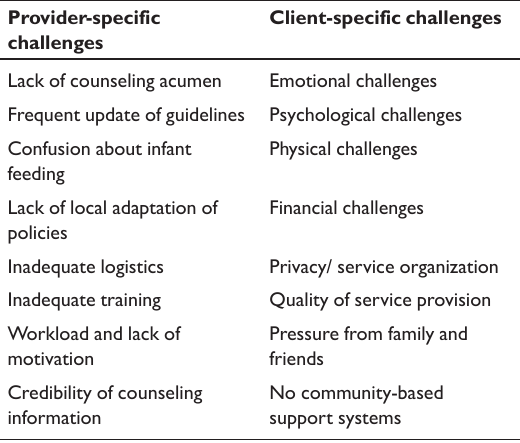
Table 1 the challenges faced by both the service pro- vid ers and their clients. Table 1 Challenges faced by PMTCT service